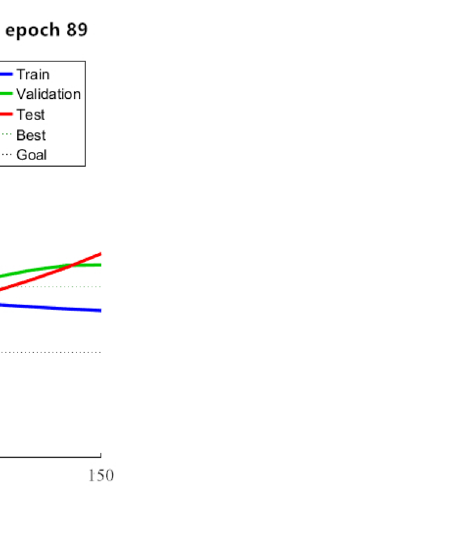
Figure 21. Error change of the GA-BPNN iterative